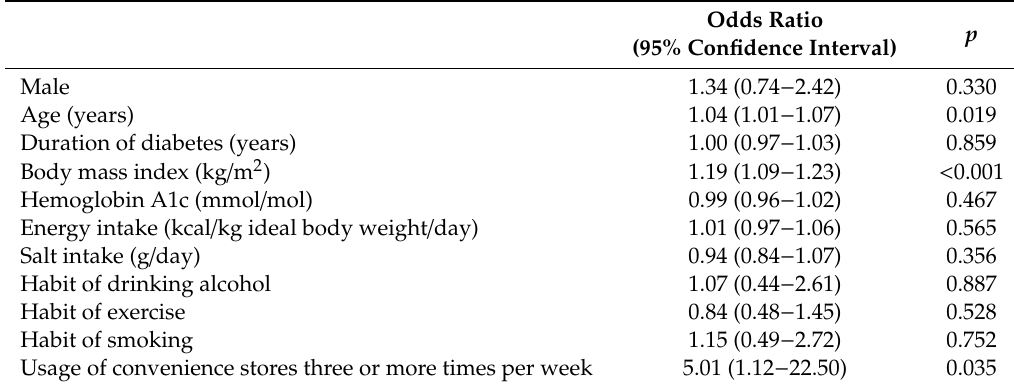
Table 3. Logistic regression analysis on the prevalence of